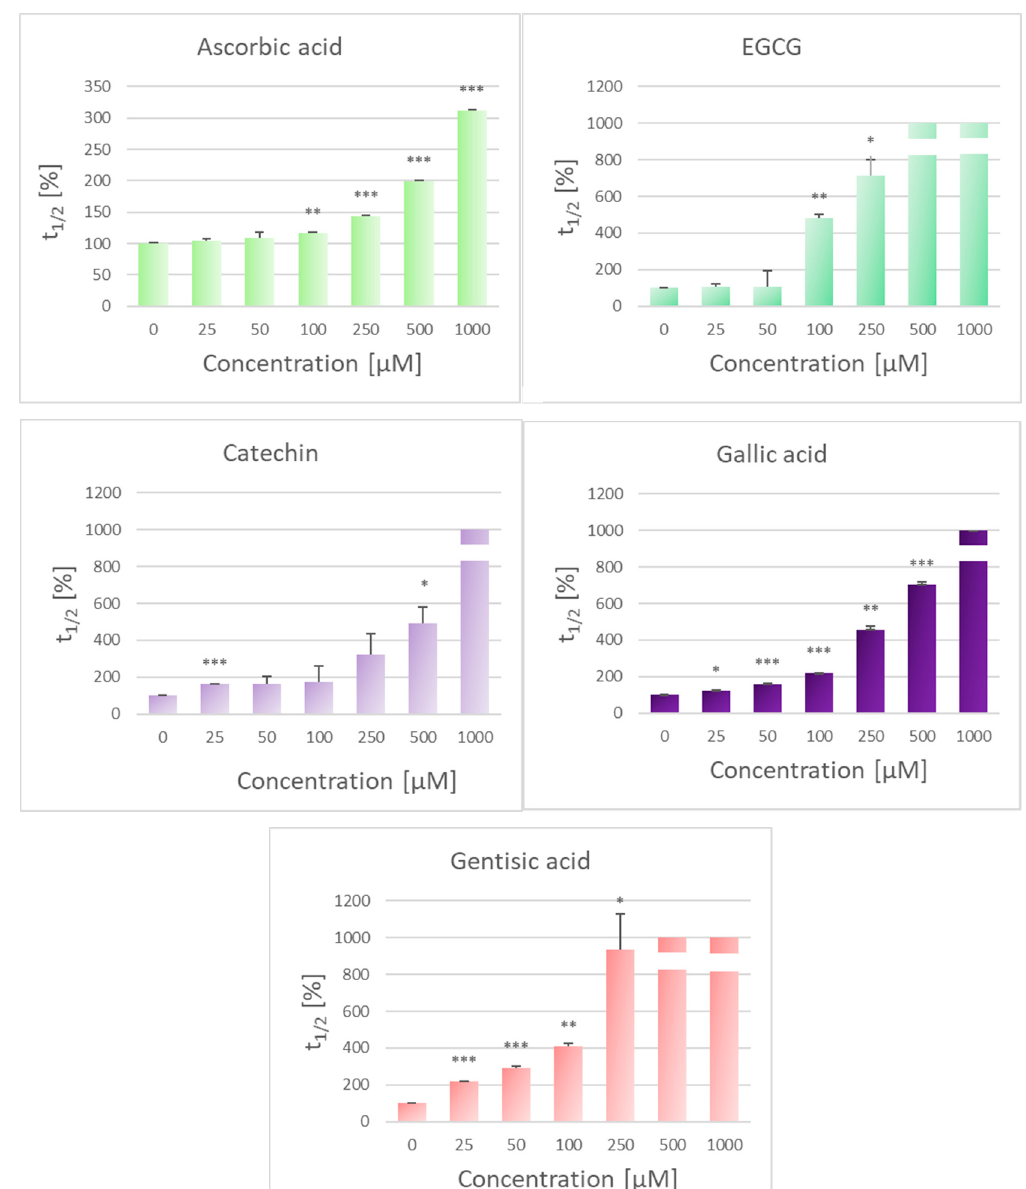
Figure 2. Effect of selected antioxidants on the AAPH-induced hemolysis of human erythrocytes. Hemolysis half-time expressed as percent of hemolysis half-time of “positive control” samples, containing no antioxidant (t 1/2 = 96.3 ± 1.4 min), assumed as 100%. The turbidity of “negative control” samples, not added with AAPH, did not change during the incubation time. * p < 0.05, ** p < 0.01, *** p < 0.001 with respect to control (100%).